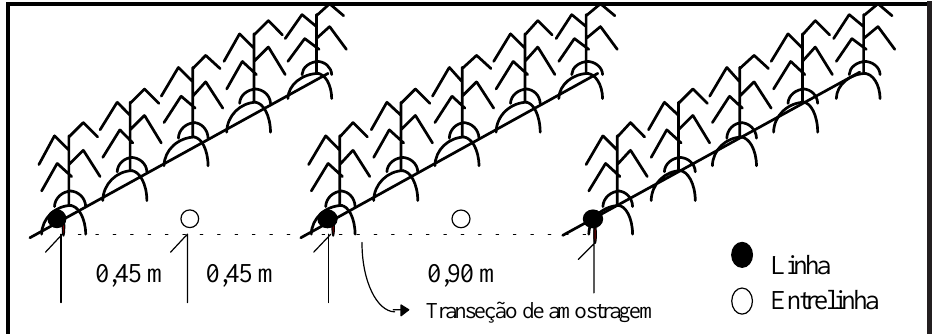
Figura 1. Esquema de coleta das amostras com estrutura indeformada em um Latossolo Roxo ao longo de um traçado perpendicular às linhas de cultivo, na linha e